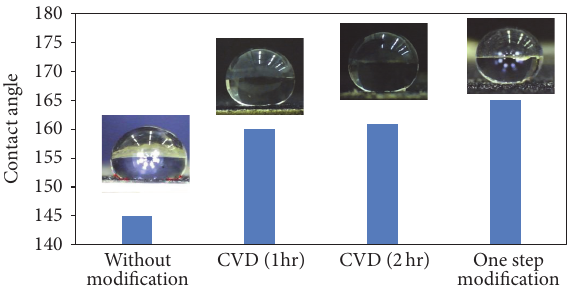
Figure 5: The effect of different modification techniques on contact angle for FG